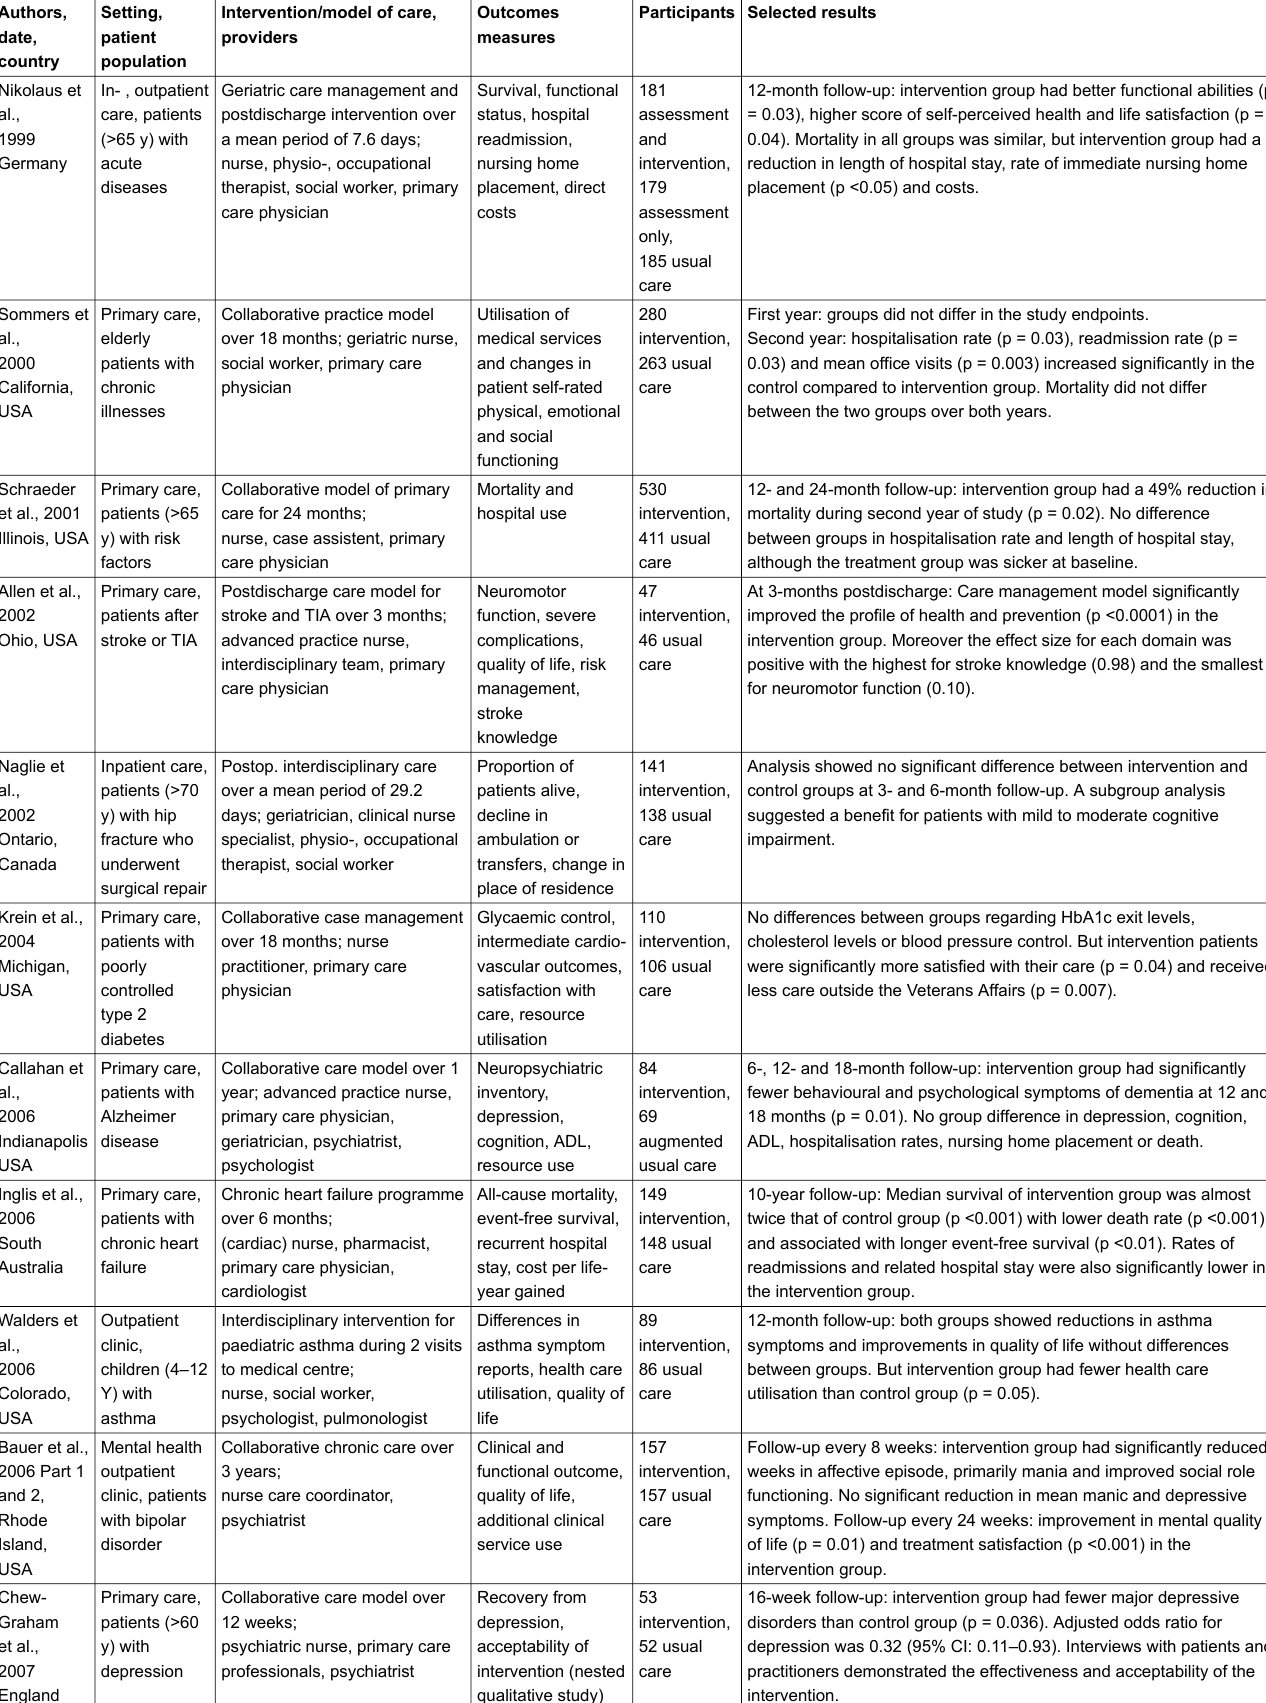
Table 1 Abbreviations: ADL= Activities of daily living/ED = emergency department/ y = years of age/ TIA = transient ischaemic attack/CI = confidence